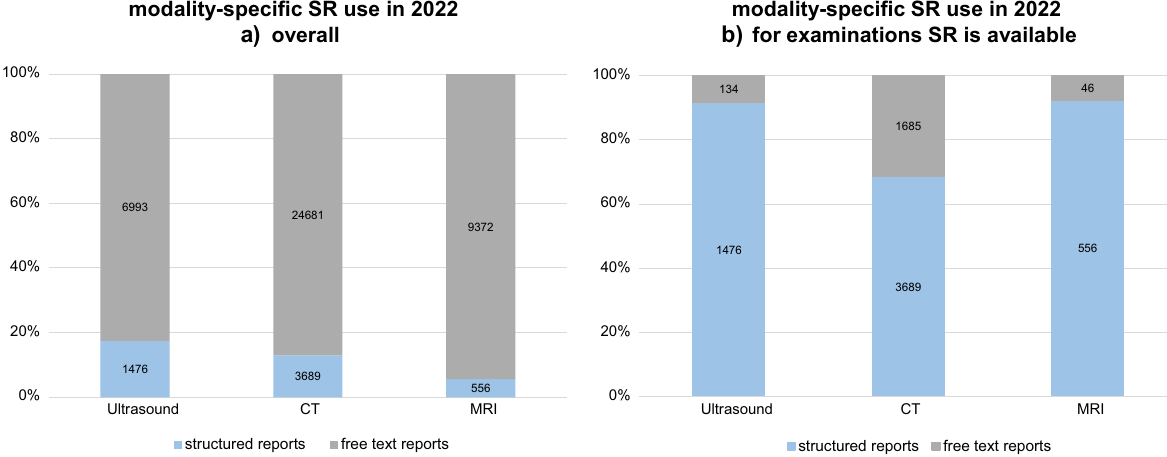
Fig. 4 Modality-specific use of SR in 2022: ( a ) for all examinations, and ( b ) for those for which SR was available, with absolute numbers for free-text reports and structured reports